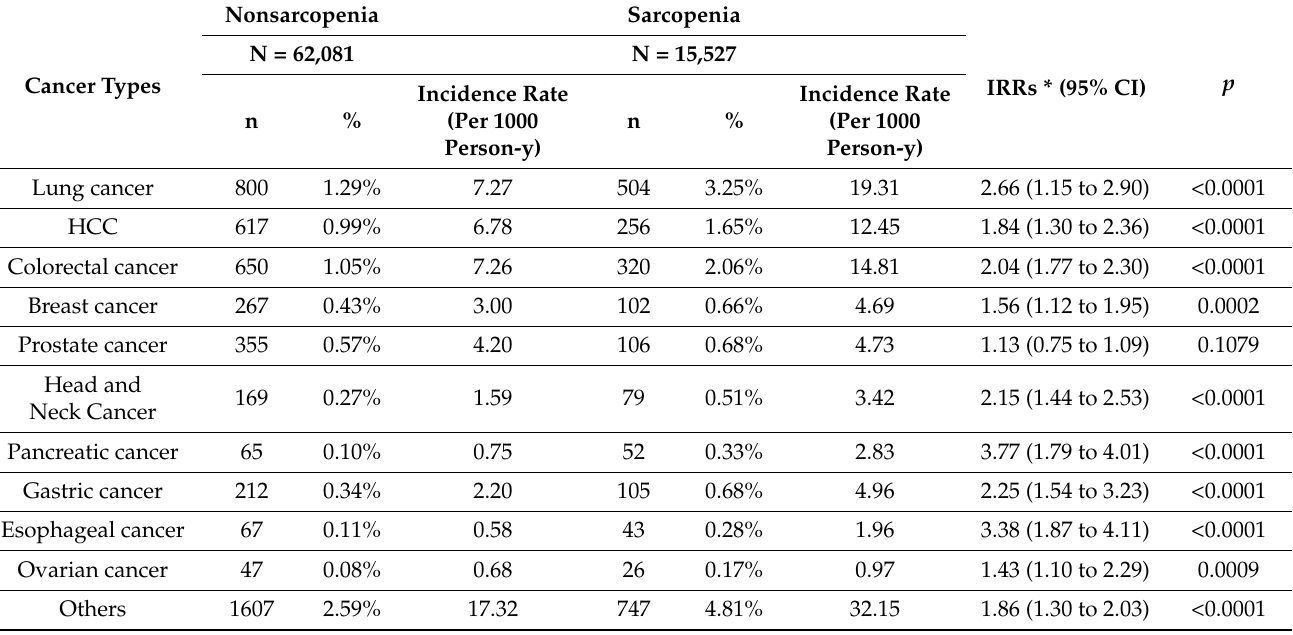
Table 3. Incidence rates and IRRs of cancer in PS-matched patients with and without